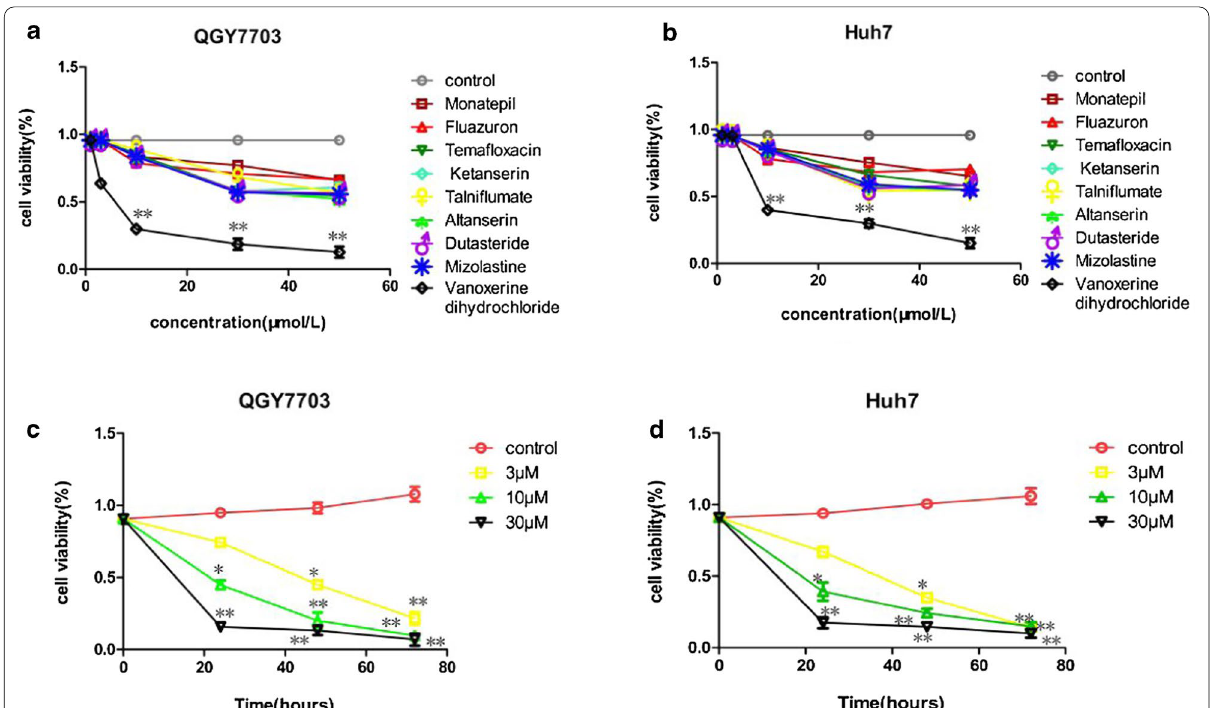
Fig. 1 The effect of nine candidate CDK4/6 inhibitors on the viability of QGY7703 and Huh7 cells. The effect of nine candidate compounds on the cell viability of a QGY7703 and b Huh7 cell lines as determined by MTT assay. Vanoxerine dihydrochloride exhibited the highest cyto‑toxicity in both cell lines. Vanoxerine dihydrochloride reduced cell viability dose‑ and time‑dependently in c QGY7703 and d Huh7 cell lines. IC50 values was calculated to be 3.79 μM for QGY7703 and 4.04 μM for Huh7. *p < 0.05, significantly different from the control PBS treatment